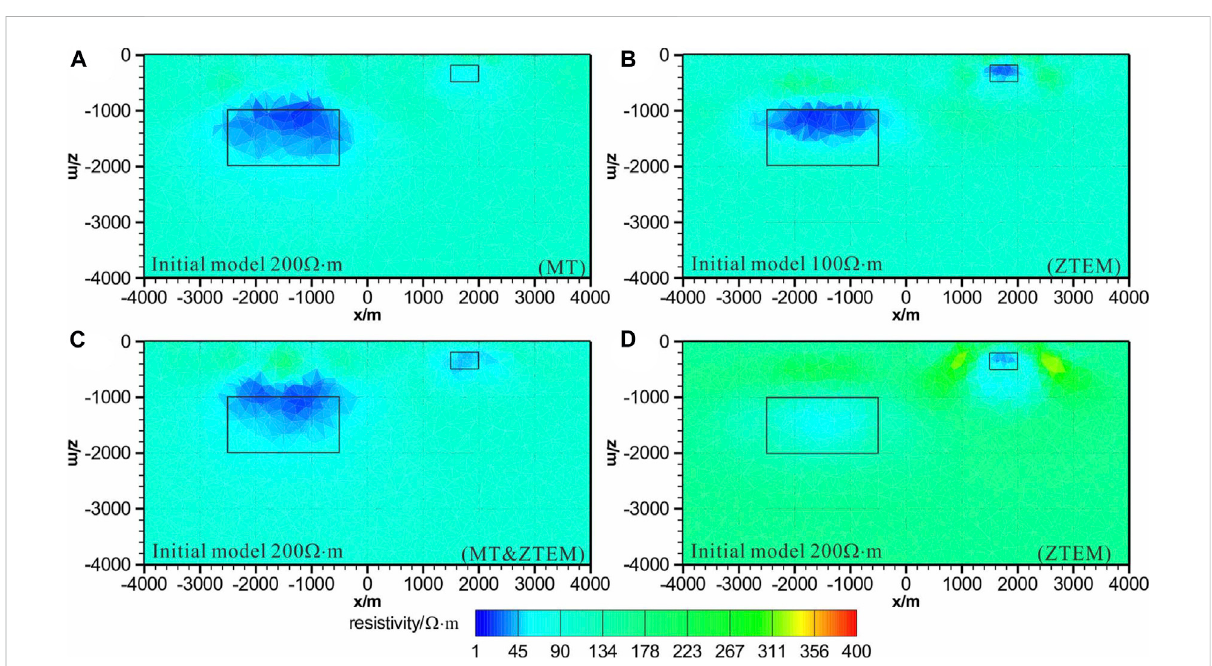
FIGURE 3 Inversion results for the synthetic model without topography respectively at the xz section for y =0 m. (A,D) and (C) are MT inversion, ZTEM inversion, and joint MT and ZTEM inversion with initial model and a 200 Ω · m half-space, respectively. (B) is the ZTEM inversion with a 100 Ω · m half-